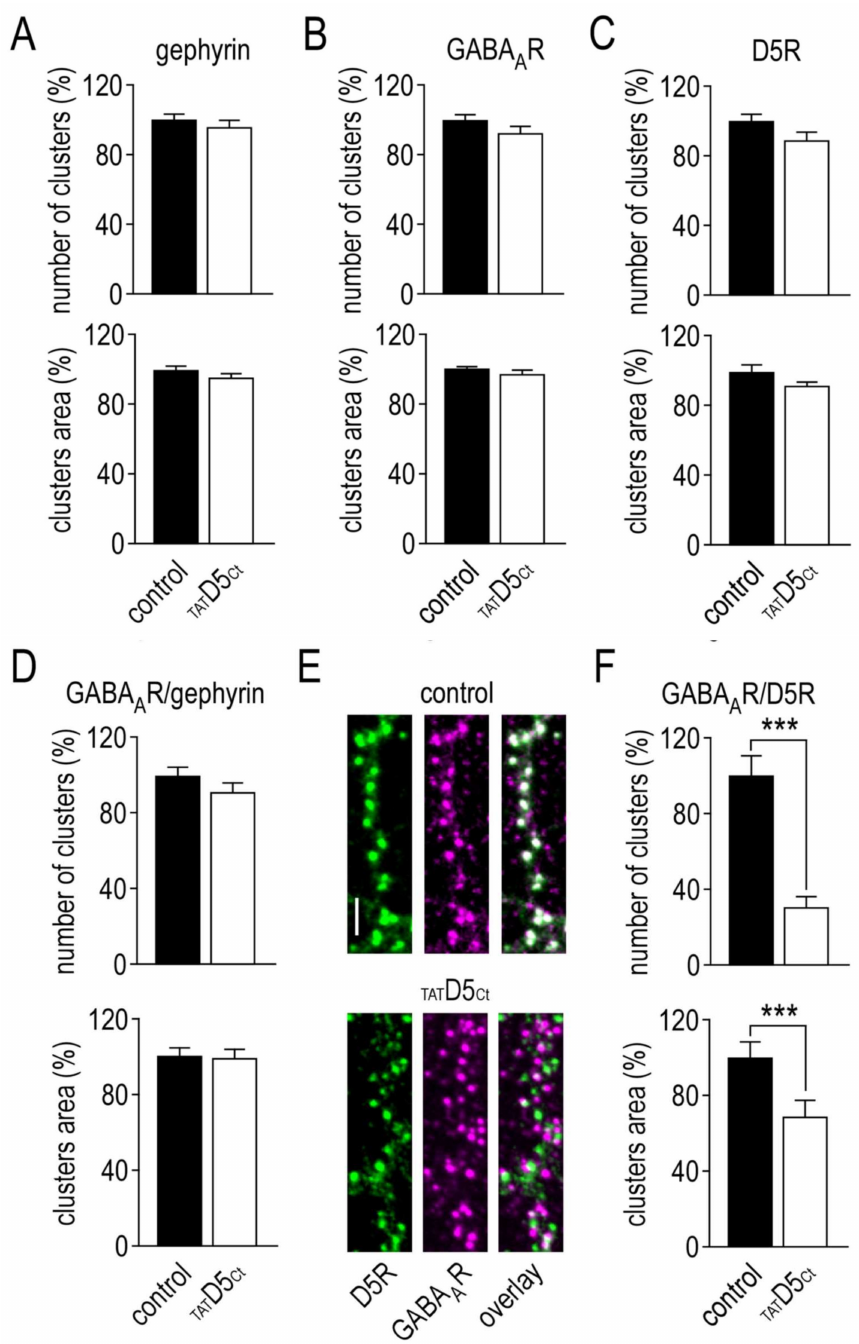
Figure 2. The disrupting peptide impairs the co-localization of GABA A and dopamine D5 receptors in hippocampal neurons. Bar graphs illustrating the impact of the disrupting peptide on the number and the mean area of the clusters of gephyrin ( A ), GABA A receptors ( B ) and dopamine D5 receptors ( C ). ( D ) Bar graphs illustrating the impact of the disrupting peptide on the synaptic GABA A receptors. ( E ) Representative images of dopamine D5 receptors (green) and GABA A receptors (purple) in control condition (upper panel) or in the presence of the disrupting peptide (lower panel). The overlapping clusters appear in white. Scale bar, 4 µ m. ( F ) Bar graphs illustrating the impact of the disrupting peptide on the overlapping clusters of GABA A and dopamine D5 receptors. Data are represented as mean ± SEM normalized to the control condition. *** p < 0.001. Nonparametric Mann–Whitney